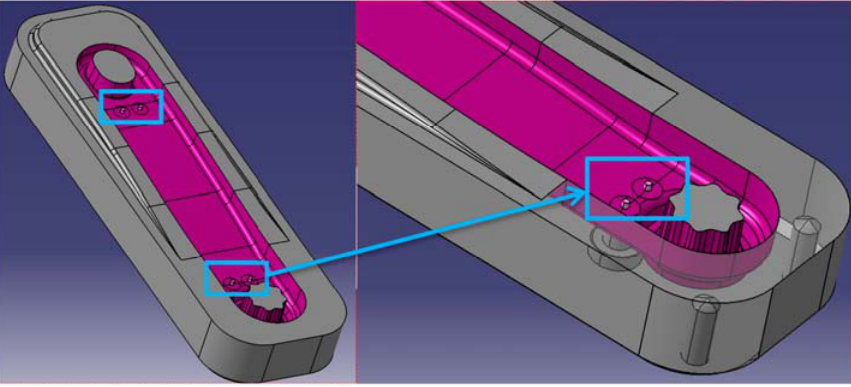
Figure 7. Detail of fixing pins in the fixed die cavity for placing the aluminium foam.